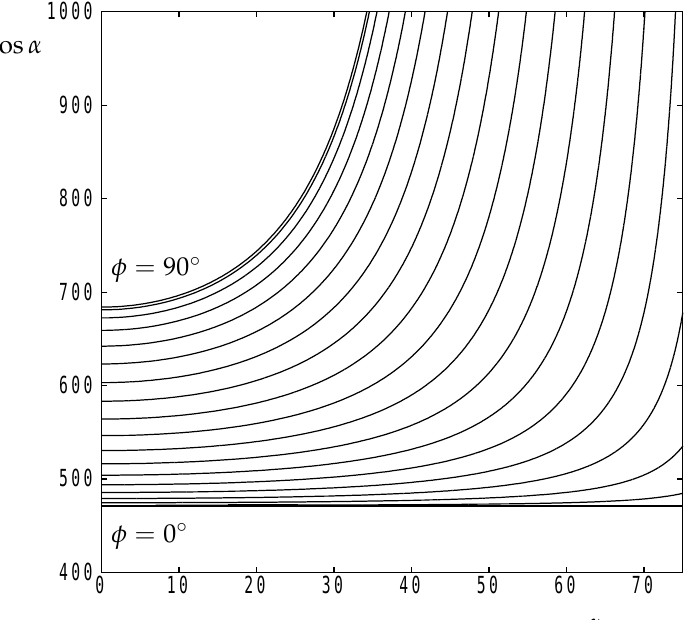
Figure 7. For ξ = 0.5. The variation with α of the critical value of Ra cos α for the roll orientations, φ = 0 ◦ , 5 ◦ , 10 ◦ , . . . , 90 ◦ .